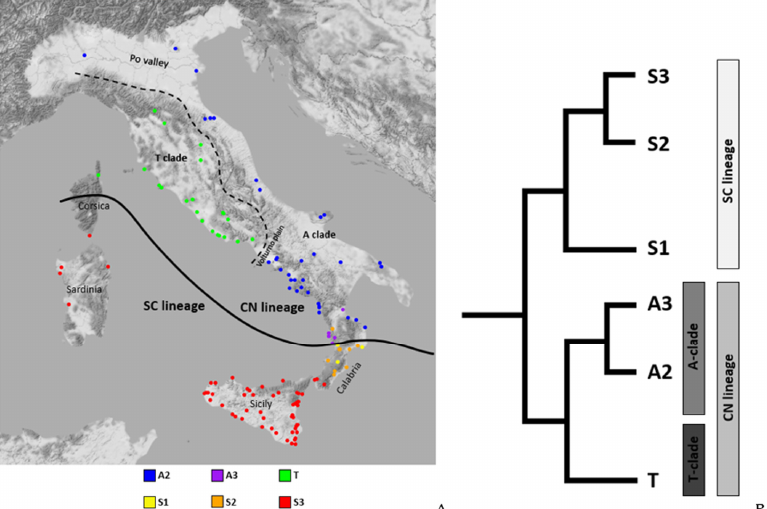
Figure 2. The geographical distribution of the main clades ( A ) and their phylogeny ( B ). Each dot represents a genotyped sample. The map and the phylogenetic tree are redrawn from Senczuk et al., 2017. In the map, the geographical region cited in the text is shown. The boundaries of the distribution of the different lines and clades are also indicated.